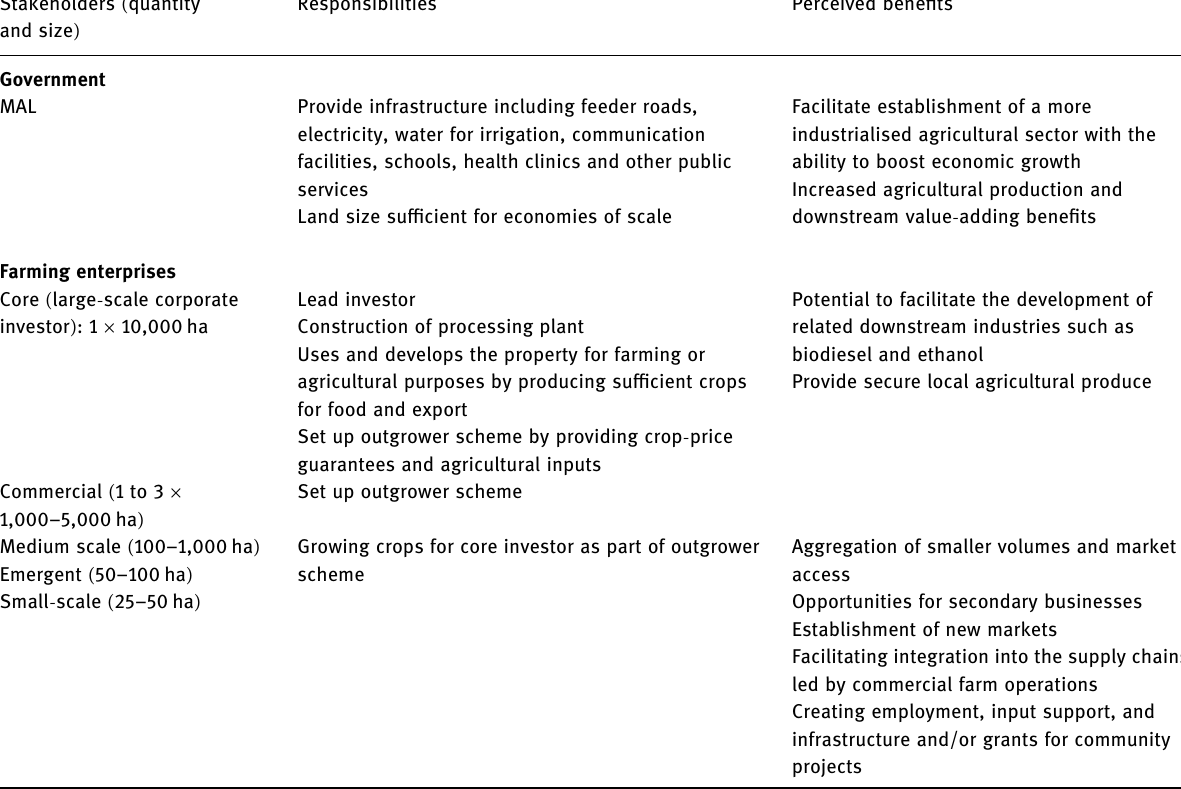
Table 1: Farm block design with government and private sector responsibilities Stakeholders (